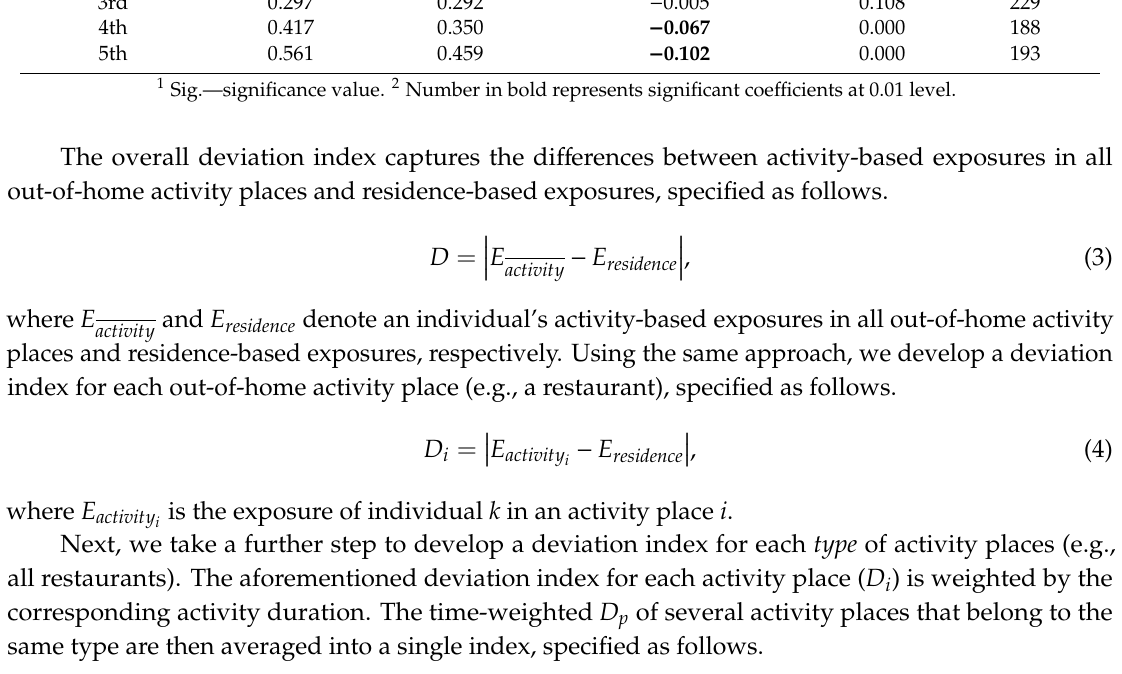
Table 2. Di ff erences between (and paired-sample t -test of) activity-based and residence-based exposures. Quintile of Residence-Based Exposure